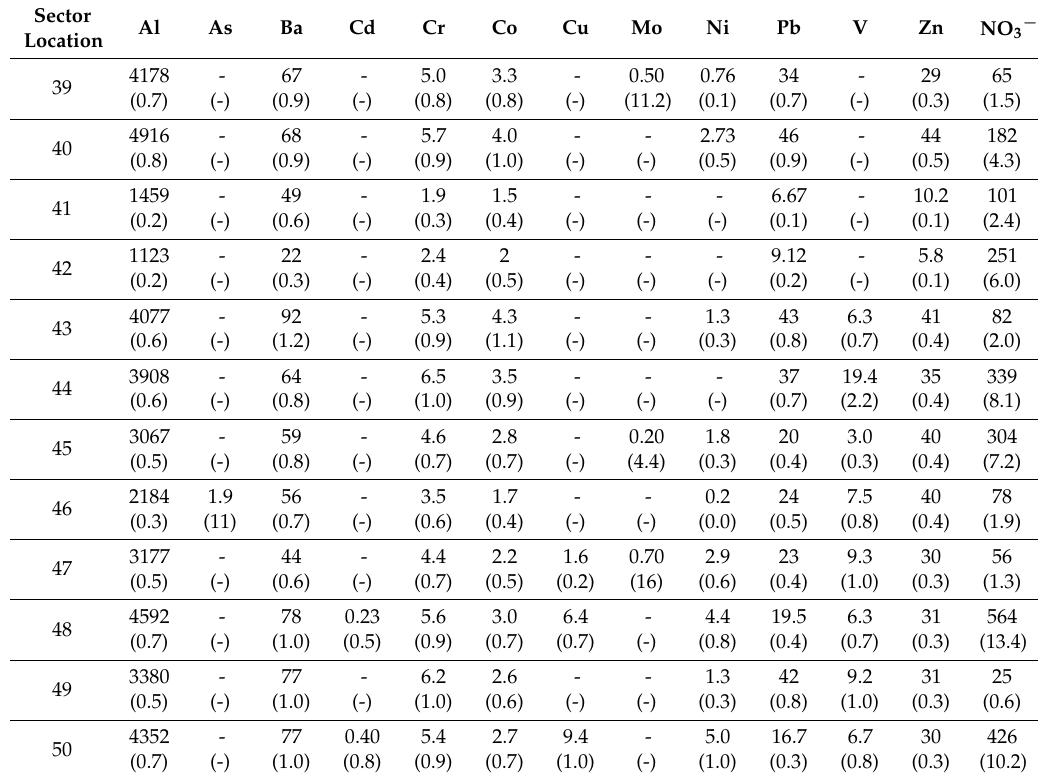
Table 6. Data for metals and NO 3 − concentrations in N